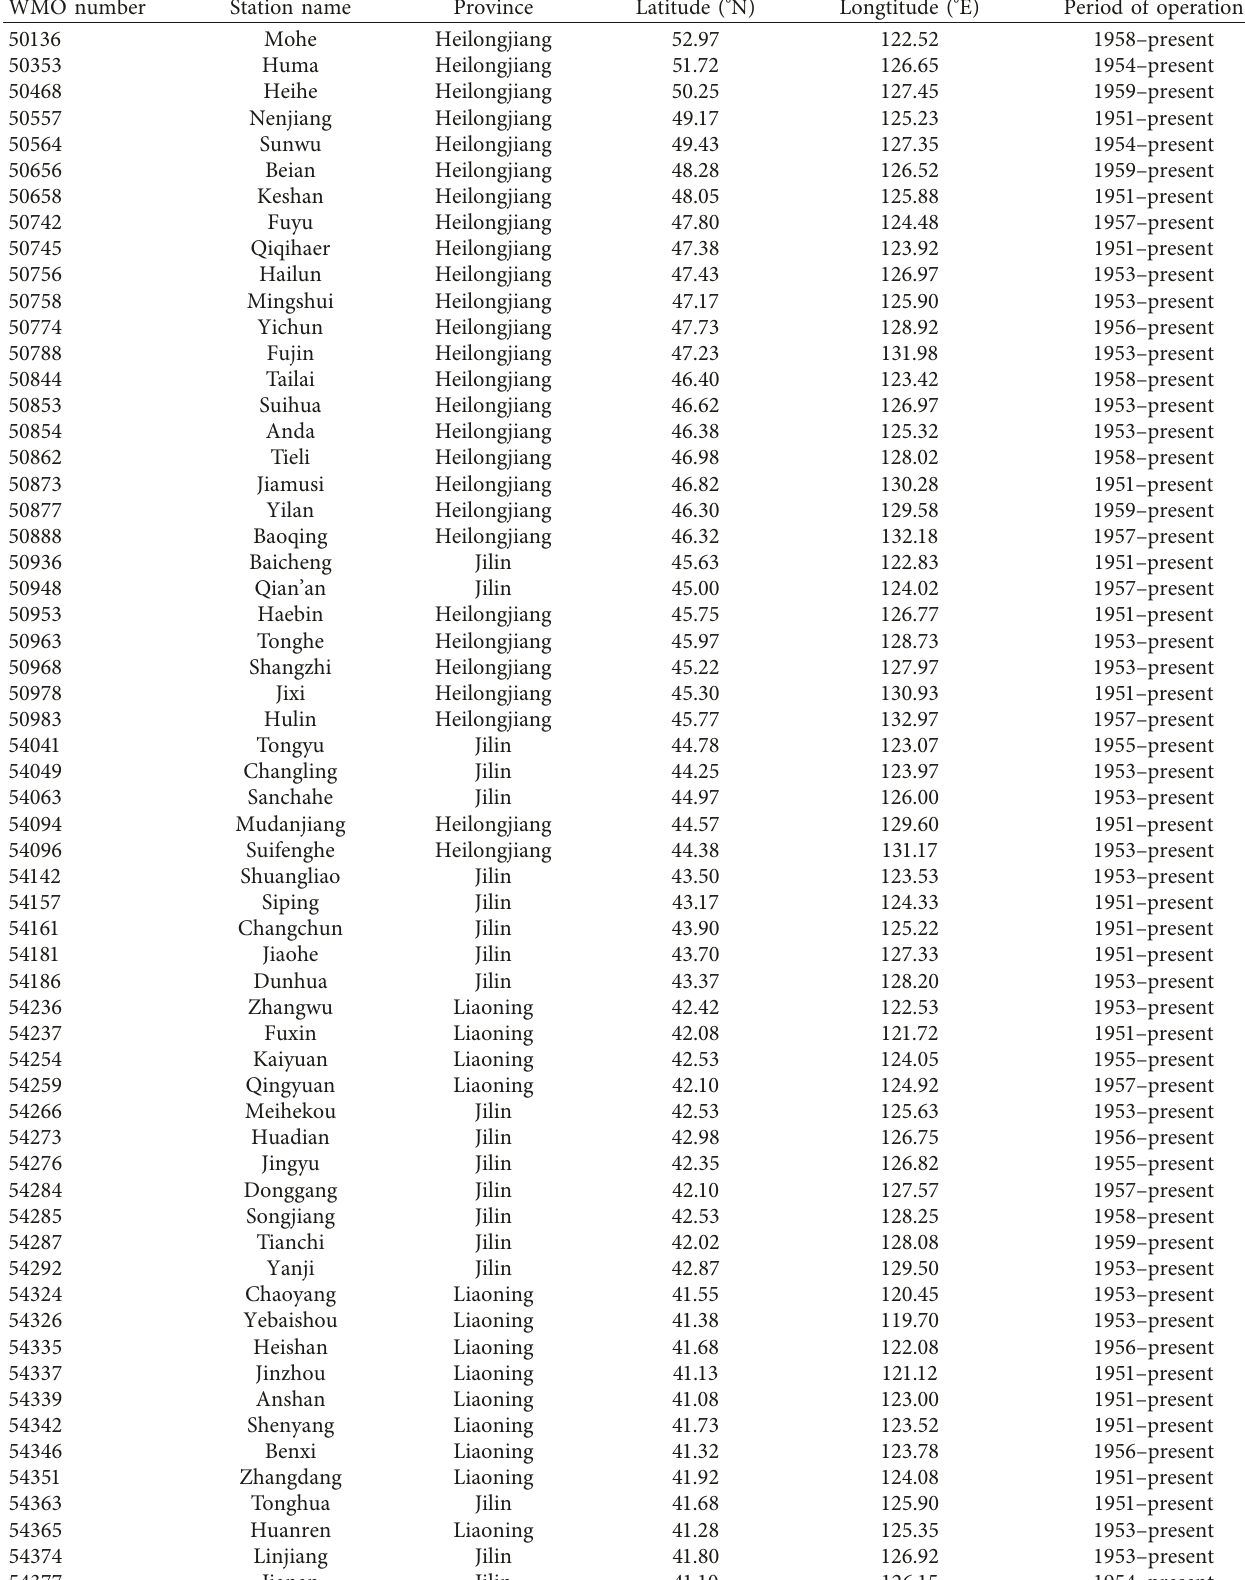
Table 1: List of stations with WMO (World Meteorological Organization) number and location. WMO